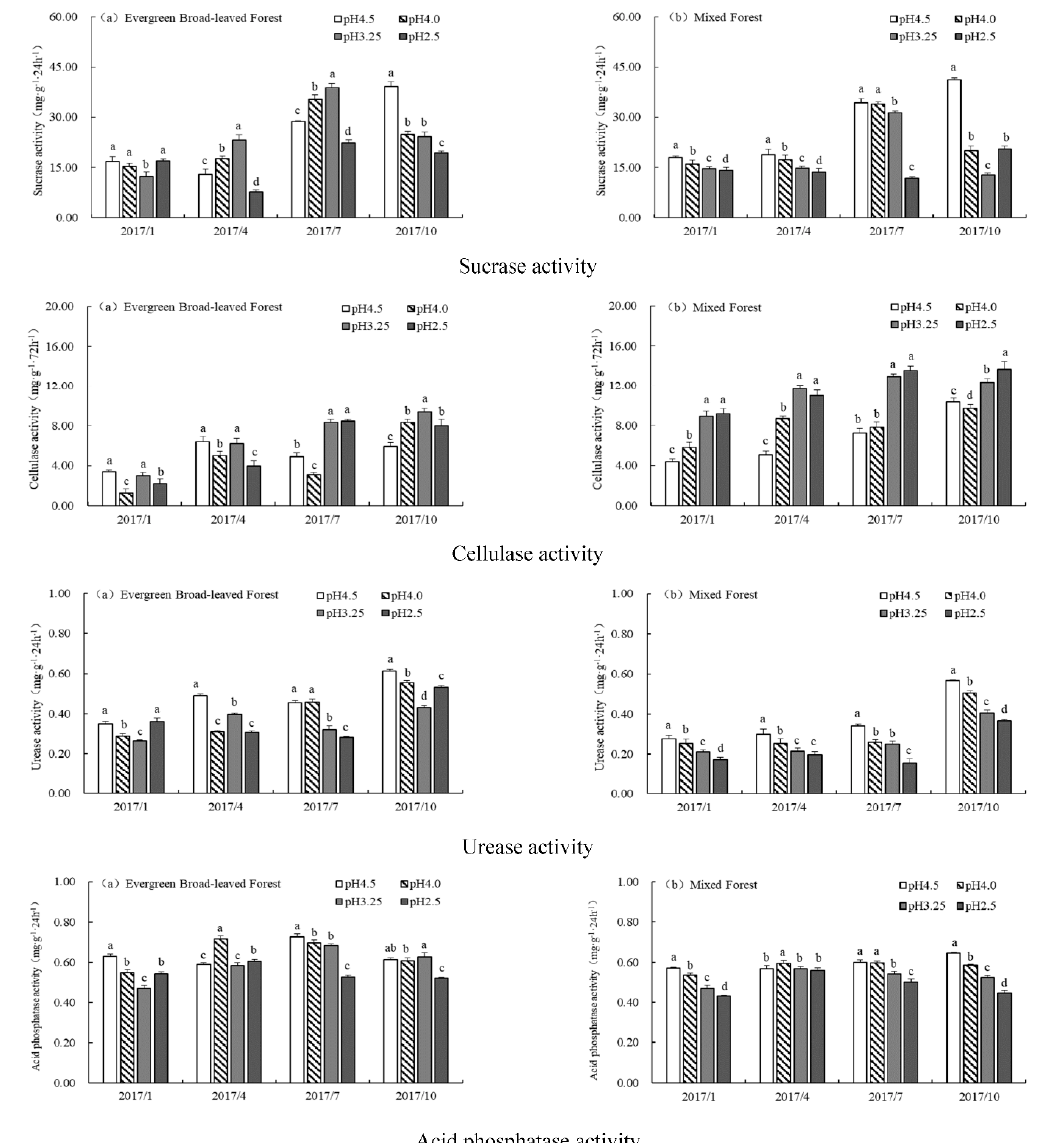
Figure 2. Soil enzyme activities in evergreen broad-leaved forest and coniferous broad-leaved mixed forest under different concentrations of acid rain (different lowercase letters indicate significant differences among soil enzyme activities under different acid rain treatments in the same period ( p < 0.05)).